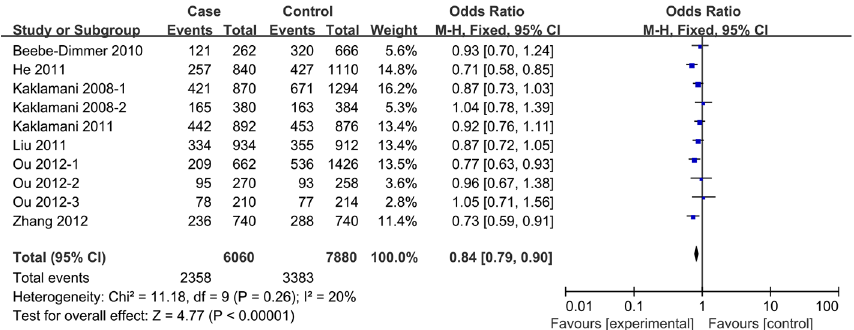
Fig 6. Forest plot of the association between ADIPOR1 SNP rs1342387(G/A) and cancer risk in an allele contrast model after sensitivity